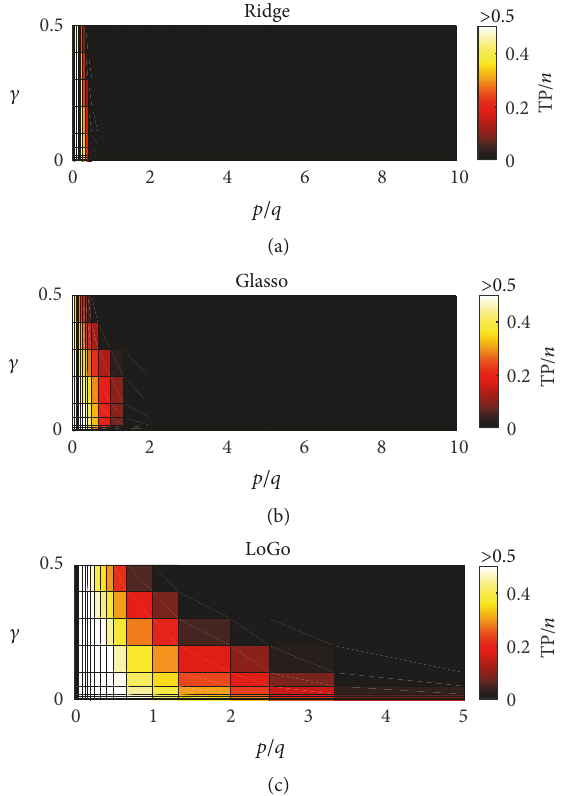
Figure 2: True positive rate: fraction of retrieved true causality links (TP) with respect to the total number of links in the process ( 𝑛 ) . The threepanelsrefertoridges,Glasso,andLoGo((a),(b),and(c)).Data are average fractions over 100